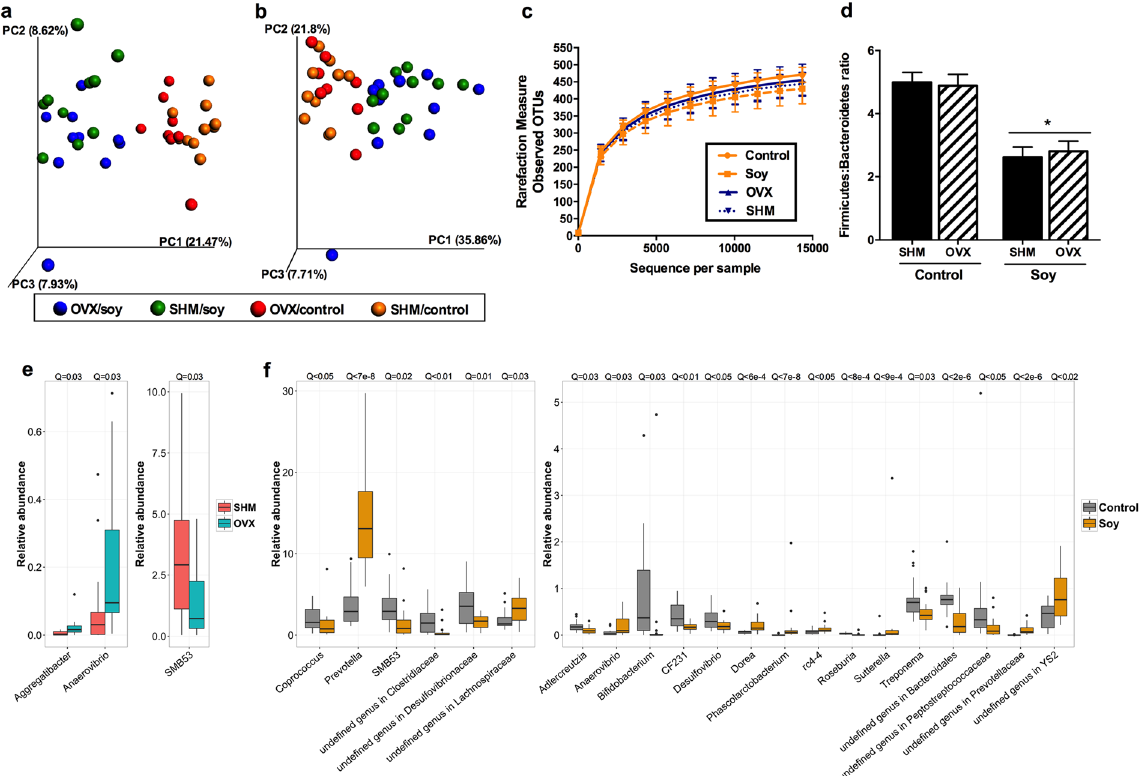
Figure 6. Cecal microbial communities of ovariectomized (OVX) vs. sham-operated (SHM) rats bred for low- running capacity fed either a soy-rich or soy-free diet. Principal coordinates analysis plots of unweighted ( a ) and weighted ( b ) UniFrac distances of cecal microbial communities performed on the 97% OTU abundance matrix revealed a distinct separation ( P = 0.01) between rats fed control vs. soy diets, but did not differ between OVX and SHM groups. Alpha diversity measures ( c ) suggest lower ( P < 0.05) species richness in rats fed soy than those fed control diet. Firmicutes:Bacteroidetes ratio ( d ) were lower ( P < 0.05) in rats fed soy than those fed control diet. Relative abundances of the differentially abundant taxa ( P < 0.05) between OVX vs. SHM ( e ) and Soy vs. Control diets ( f ). False discovery rate corrected P values (Q vales) were calculated using MaAsLin. The box represents the first and third quartiles (i.e., the 25 th and 75 th percentiles); error bars indicate 95% confidence interval of